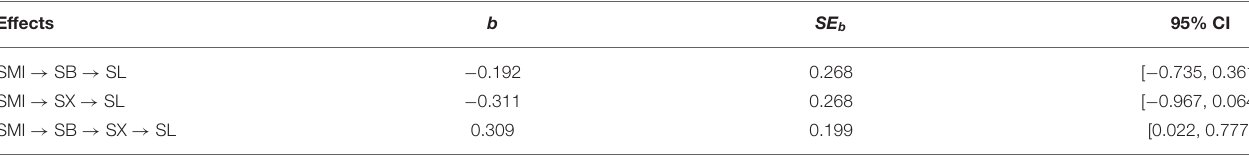
TABLE 3 | Indirect effects of the severity of the mental illness on sick